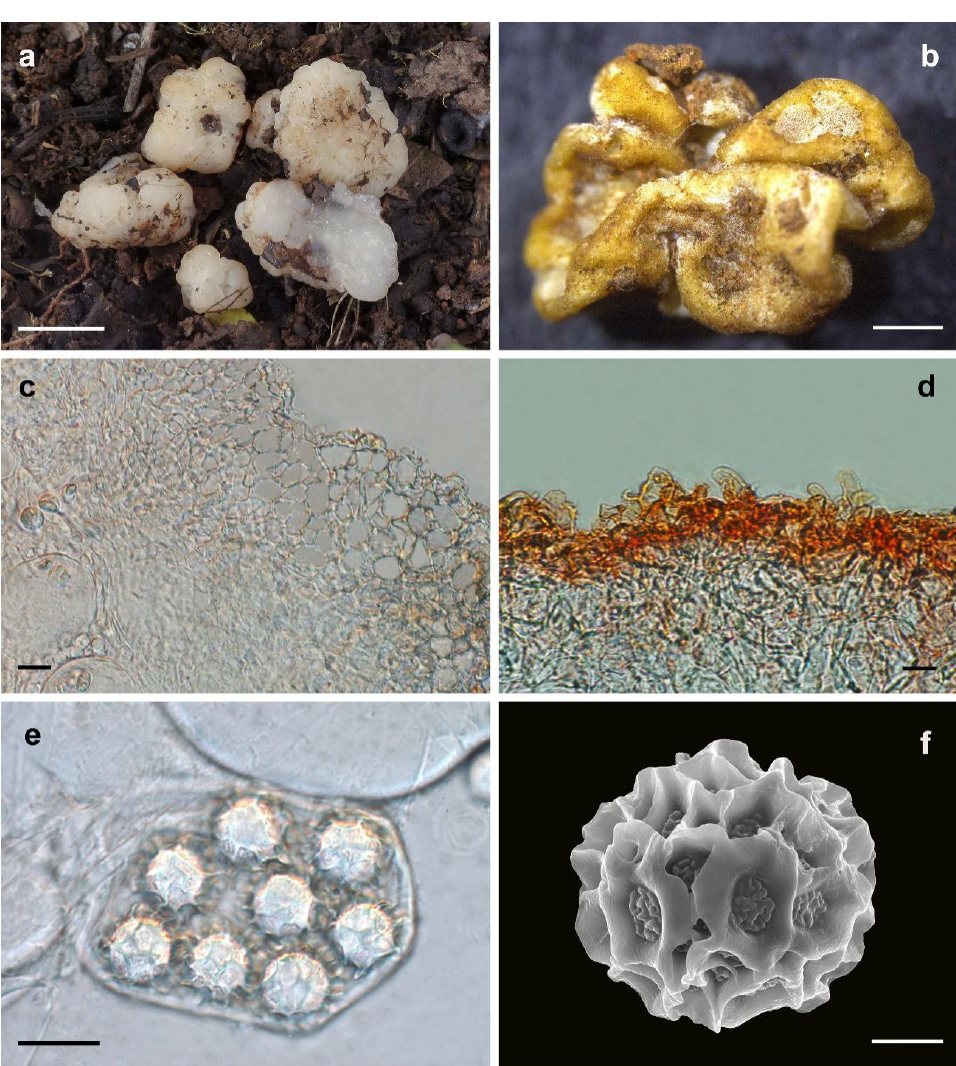
Figure 3. Hydnobolites translucidus (Holotype, HKAS95861). ( a ) Fresh ascomata and gleba; ( b ) dried ascoma; ( c ) peridium; ( d ) paraphyses; ( e ) asci and ascospores under LM; ( f ) ascospore under SEM. Scale bars: a = 1 cm; b = 1 mm; c–e = 20 µm; f = 5 µm. 3.2.2. Hydnobolites subrufus S.P. Wan and F.Q. Yu, sp. nov.